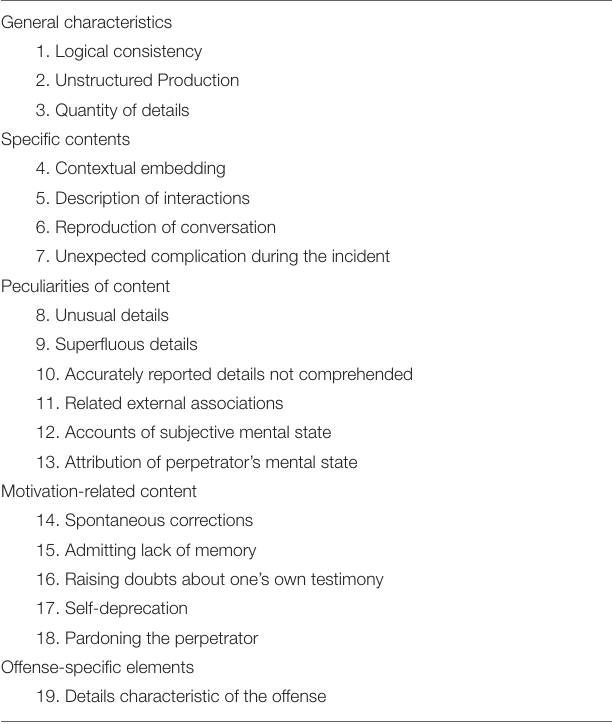
TABLE 1 | Original compilation of CBCA criteria (Steller and Köhnken, 1989). General